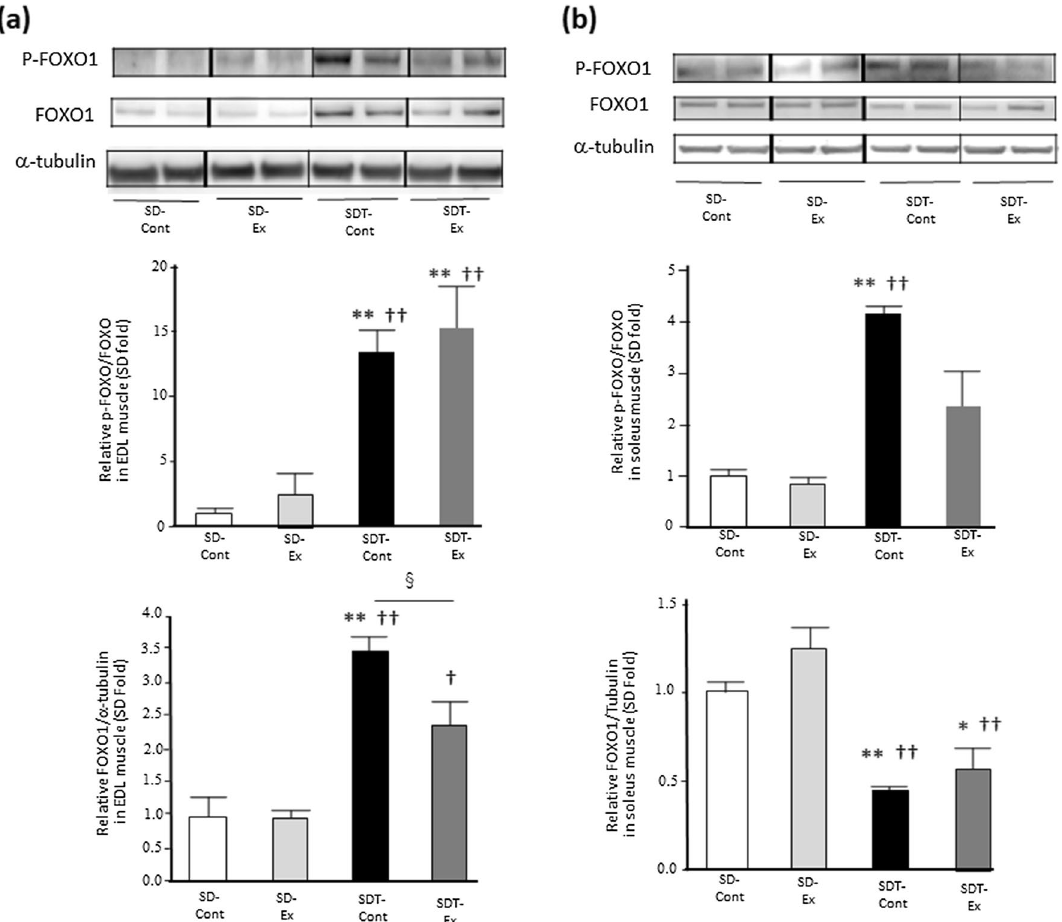
Fig. 3 Protein expression of phosphorylated forkhead box protein O1 (FOXO1) related to protein degradation in the extensor digitorum longus (EDL) and soleus muscles. Protein expression of phosphorylated forkhead box protein O1 (FOXO1) ( a : EDL, b : soleus) in the EDL and soleus muscles as determined by western blot analysis. Entire images of western blotting are shown in online Additional file 1: Fig. S4. Values are presented as mean standard error of the mean. SD‑Cont group, n 5; SD‑Ex group, n 5; SDT‑Cont group, n 6; and SDT‑Ex group, n 6. * P < 0.05 and ± = = = = ** P < 0.01 vs. the SD‑Cont group, † P < 0.05 and †† P < 0.01 vs. the SD‑Ex group, and § P < 0.05 and §§ P < 0.01 vs. the SDT‑Cont